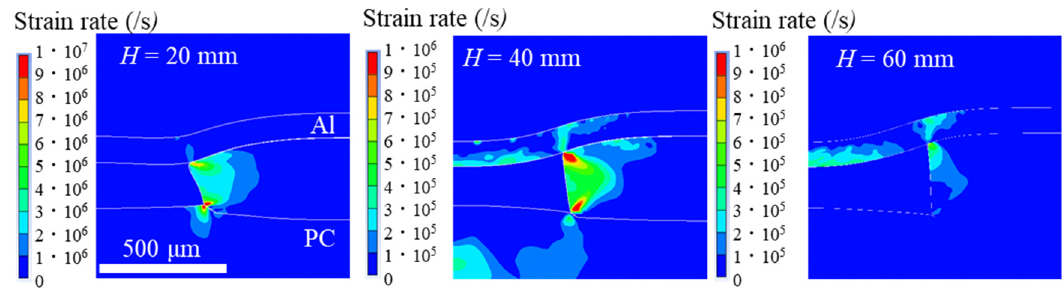
Figure 7. High strain-rate regions during imprinting.